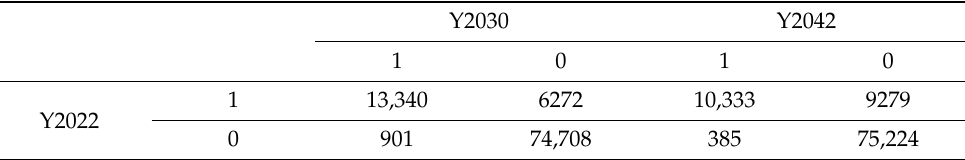
Table 6. Cross table for deriving management area where 1 indicates habitat area and 0 indicates non-habitat area (Unit: km 2